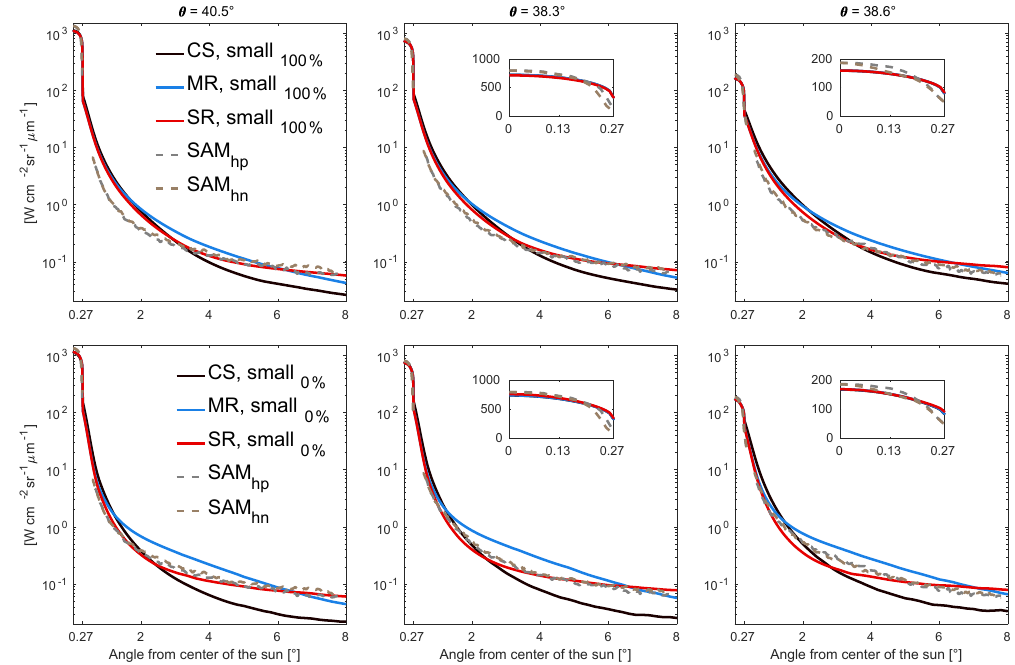
Figure 13. Comparison of SAM measured (hp and hn for the horizontal profiles to the right and left from the center of the sun) and simulated radiances at three measurement times during flight A. For the simulations, the large A distribution with 100 and 0% of measured concentration of small ice crystals is used with τ and θ values listed in Table 4. Smooth (CS) and rough (MR and SR) ice crystals are considered.